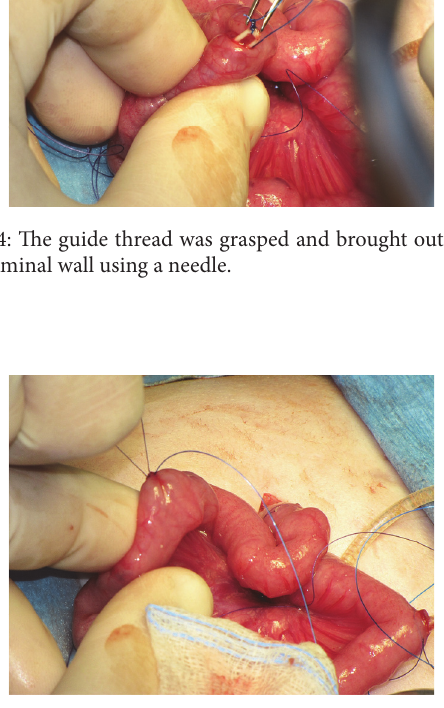
Figure 5: A suture was placed to close the opening of the bowel wall, and the suture was used to fix the bowel wall to the peritoneum of the abdominal